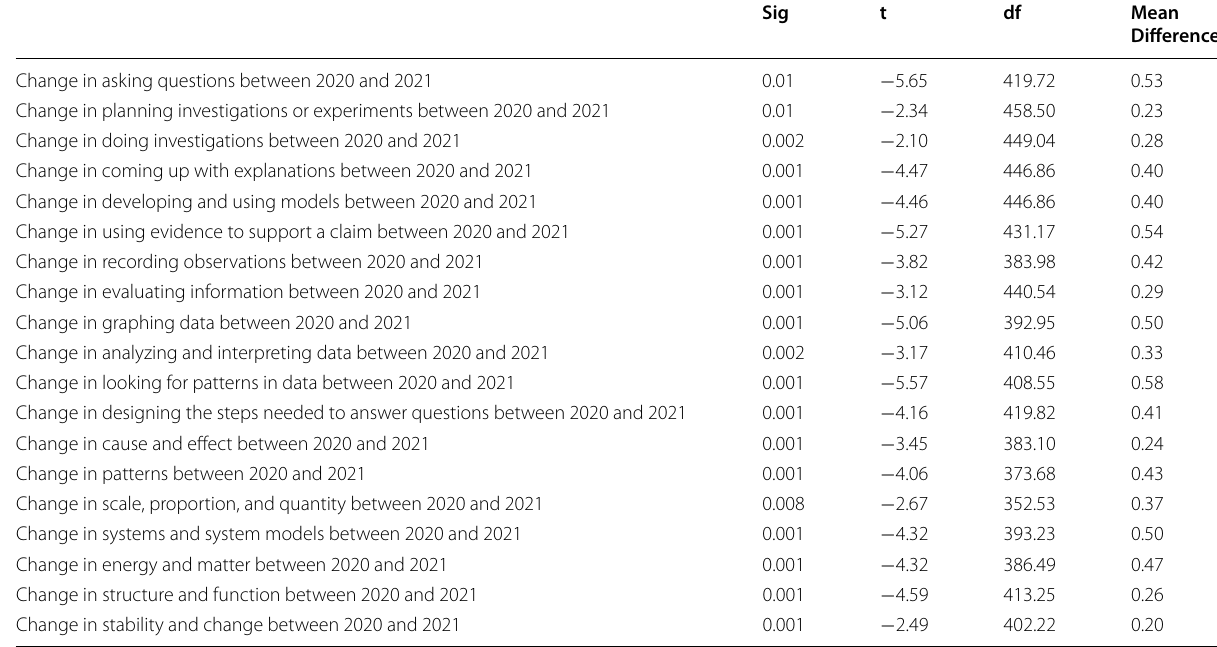
Note: Scale is 0